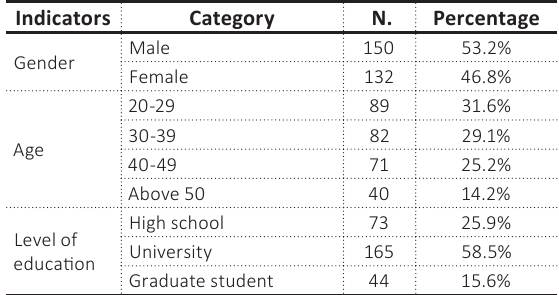
Table 1. Respondents’ statistics